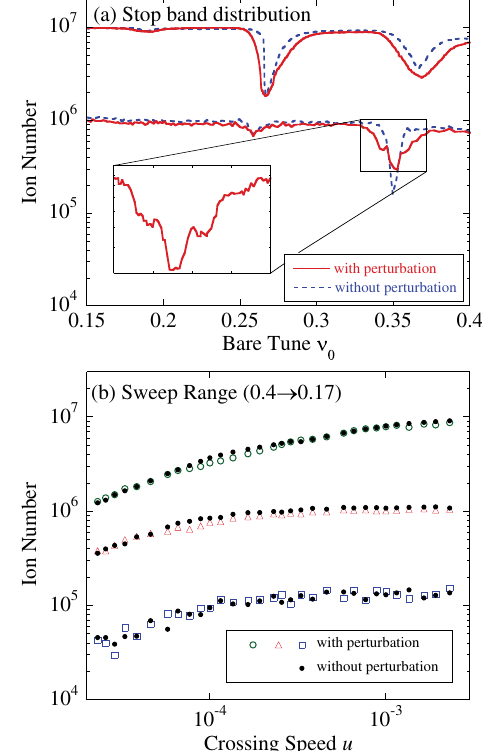
FIG. 13. Experimental results with the perturbation wave on. The error-induced sinusoidal voltage in Fig. 2 is applied to the quadrupole electrodes in addition to the primary focusing rf potential. (a) Stop-band distribution at relatively high initial ion number ( N in (cid:3) 10 6 and 10 7 ). The plasma storage period in each measurement at a fixed tune is 1 ms. The third-order stop band at N in (cid:3) 10 6 is enlarged with more data points to elucidate the existence of sidebands rising. The two sidebands eventually get together with the large central stop band at higher density, creating a single widened instability region in the vicinity of (cid:5) 0 (cid:3) 1 = 3 . For reference, the corresponding results without the perturbation (blue line in Fig. 8) are plotted with broken lines. (b) Number of remaining ions after resonance crossing vs speed of bare-tune sweep. The experimental conditions are identical to those considered in Fig. 10, except for the excitation of the error- induced wave. The results in Fig. 10 are replotted with black